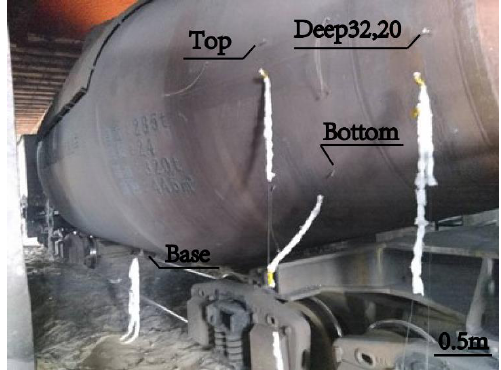
Figure 5. Torpedo ladle and measurement positions.